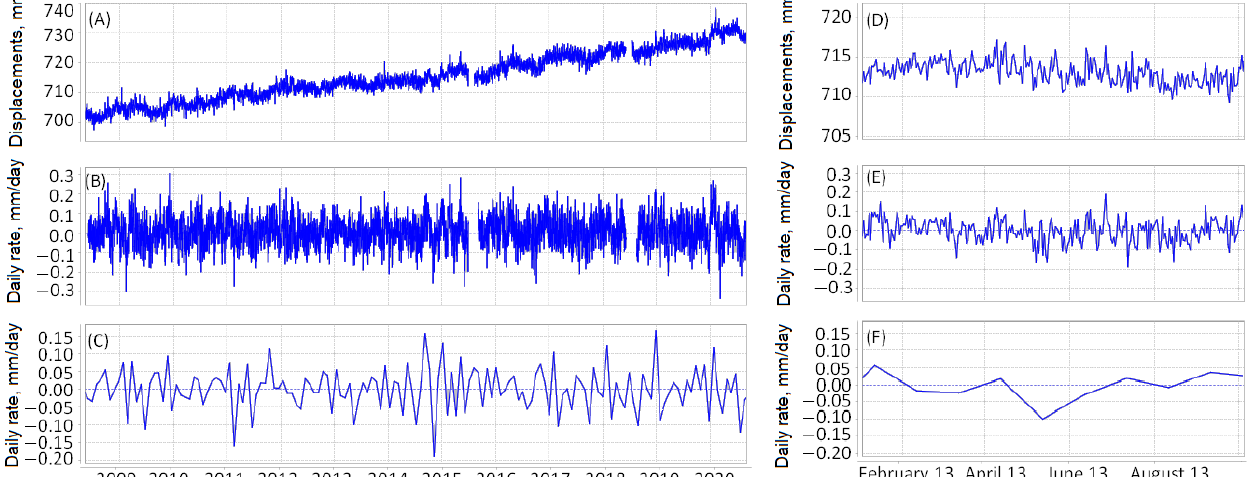
Figure 7. Time series of displacements in the N–S direction of the Californian receiving station at 39.49 ◦ N and 123.2 ◦ W. ( Left ) Interval 1 January 2008–14 November 2020. ( Right ) Interval 1 January 2013–1 October 2013. ( A , D ) time series of coordinates y ( t ) of the station (mm); ( B , E ) time series of daily rates g yk ( t ) of the station (mm/day); ( C , F ) time series V yn ( t ) at the point n of the field V y